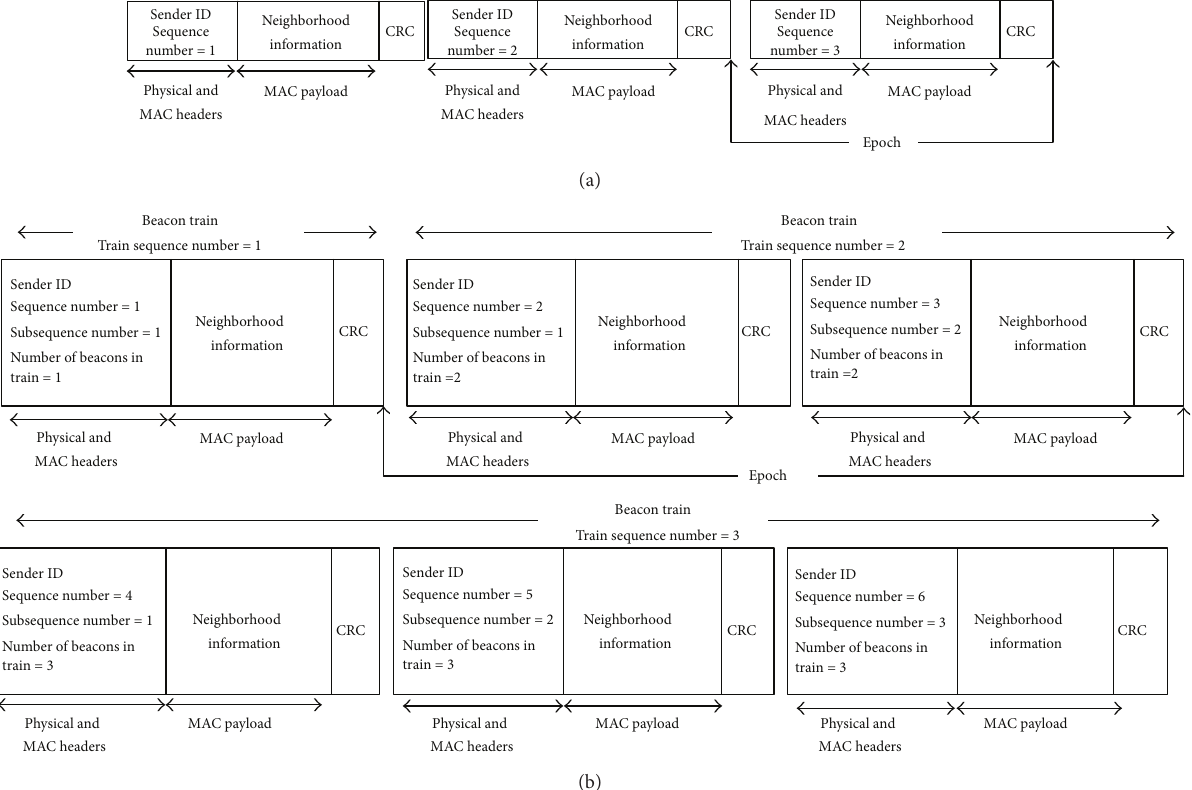
Figure 2: (a) Single-beaconing approach. (b) Multiple-beaconing